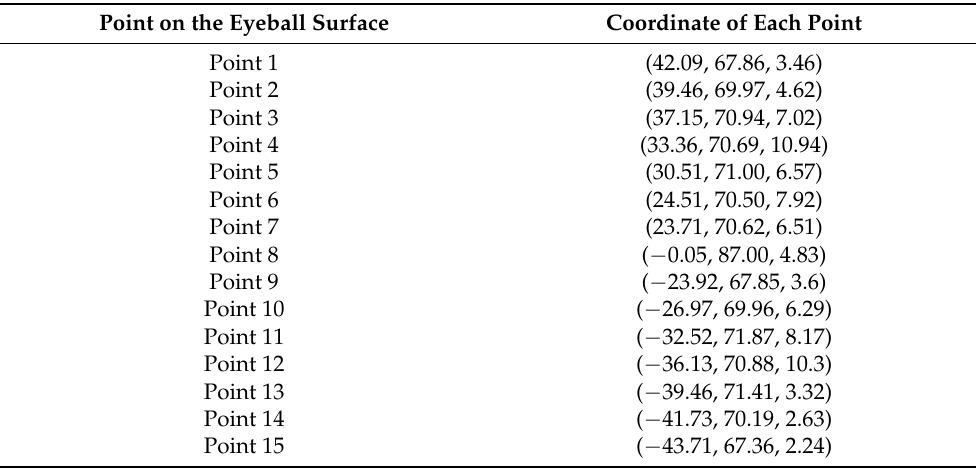
Table 5. The coordinate of each point on the eyeball surface for observing the transition of the electric field value [14].